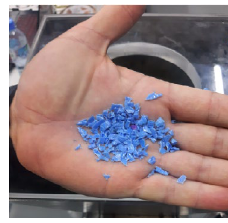
(a) Flakes 10 mm in size. (b) Flakes 8 mm in size. (c) Flakes 5 mm in